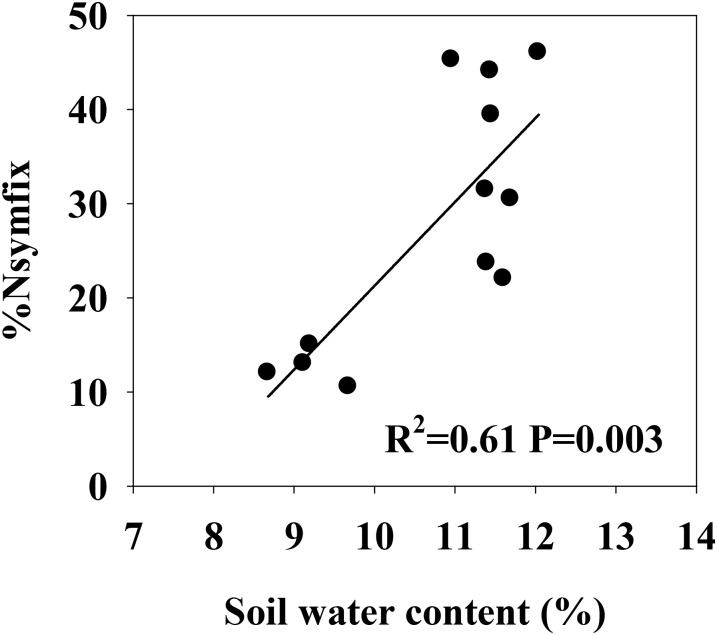
Linear relationship between soil water content (0–10 cm) and %Nsymfix of M. sativa.